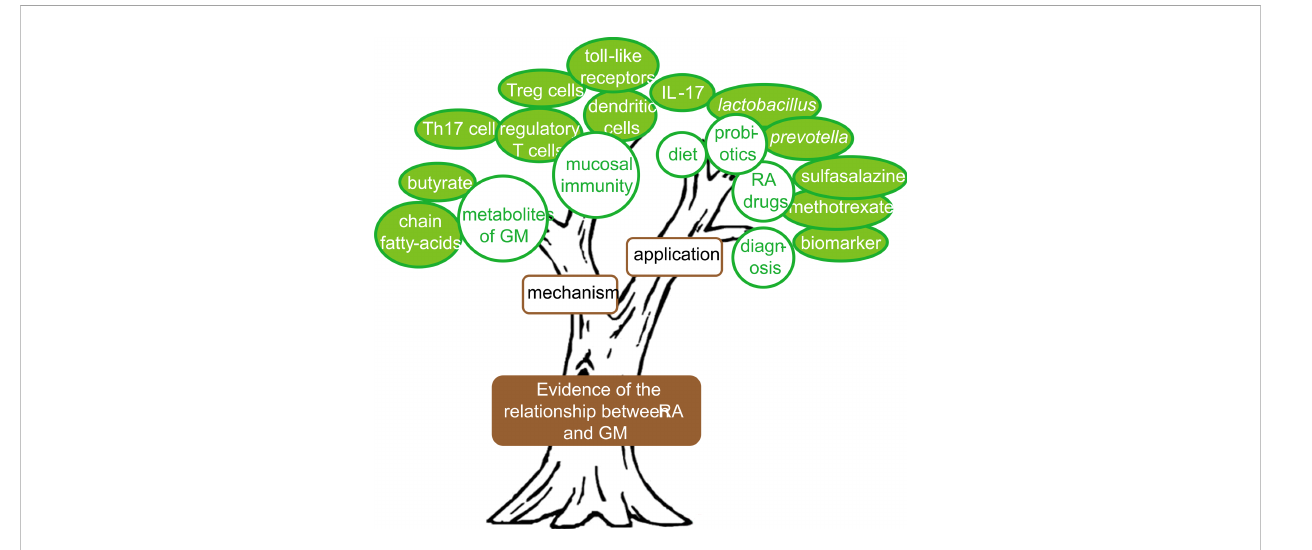
FIGURE 9 Research structure tree summarized from keywords